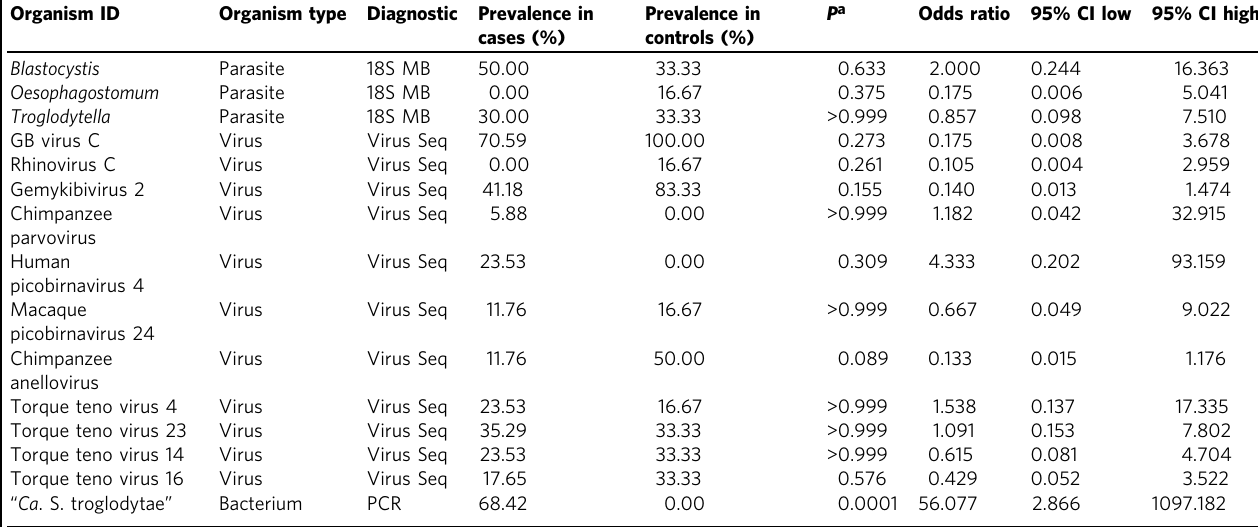
Table 1 Case/Control statistical summary. Organism ID Organism type Diagnostic Prevalence in